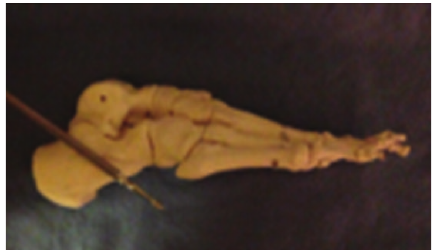
Figure 4: Category 2 partial calcanectomy: > 50% resected.